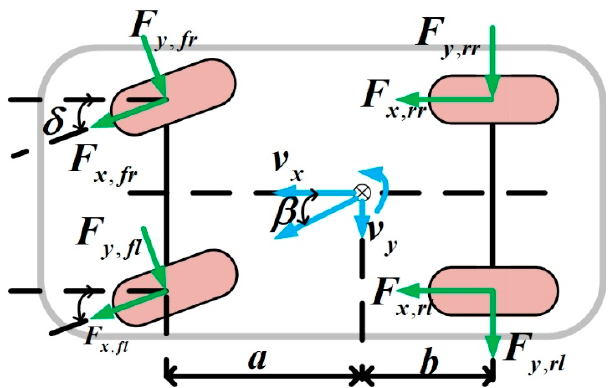
Figure 2. Four-wheeled vehicle dynamics.